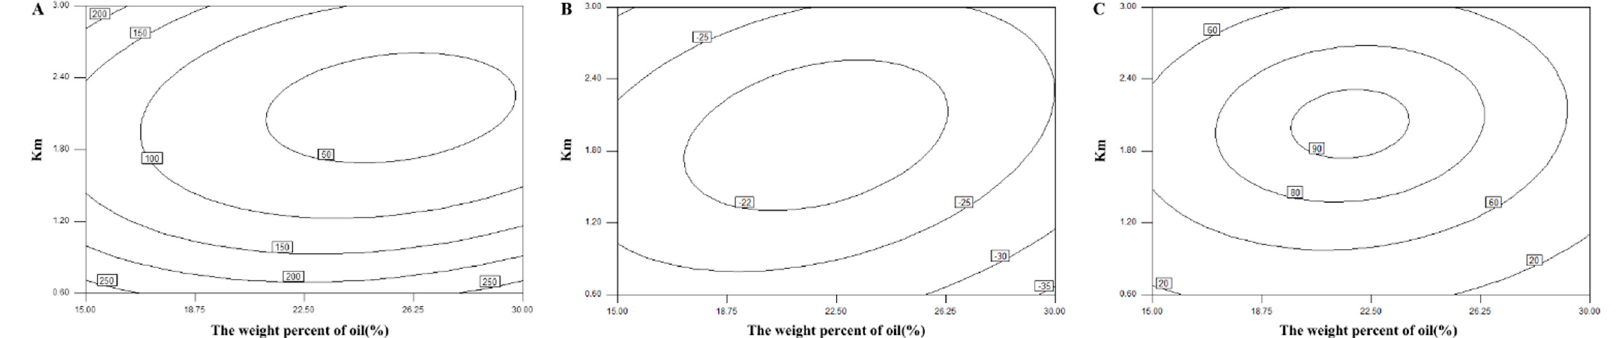
Figure 3. Contour maps of droplet size ( A ); zeta potential ( B ); and percent drug dissolution efficiency after 20 min ( C ).